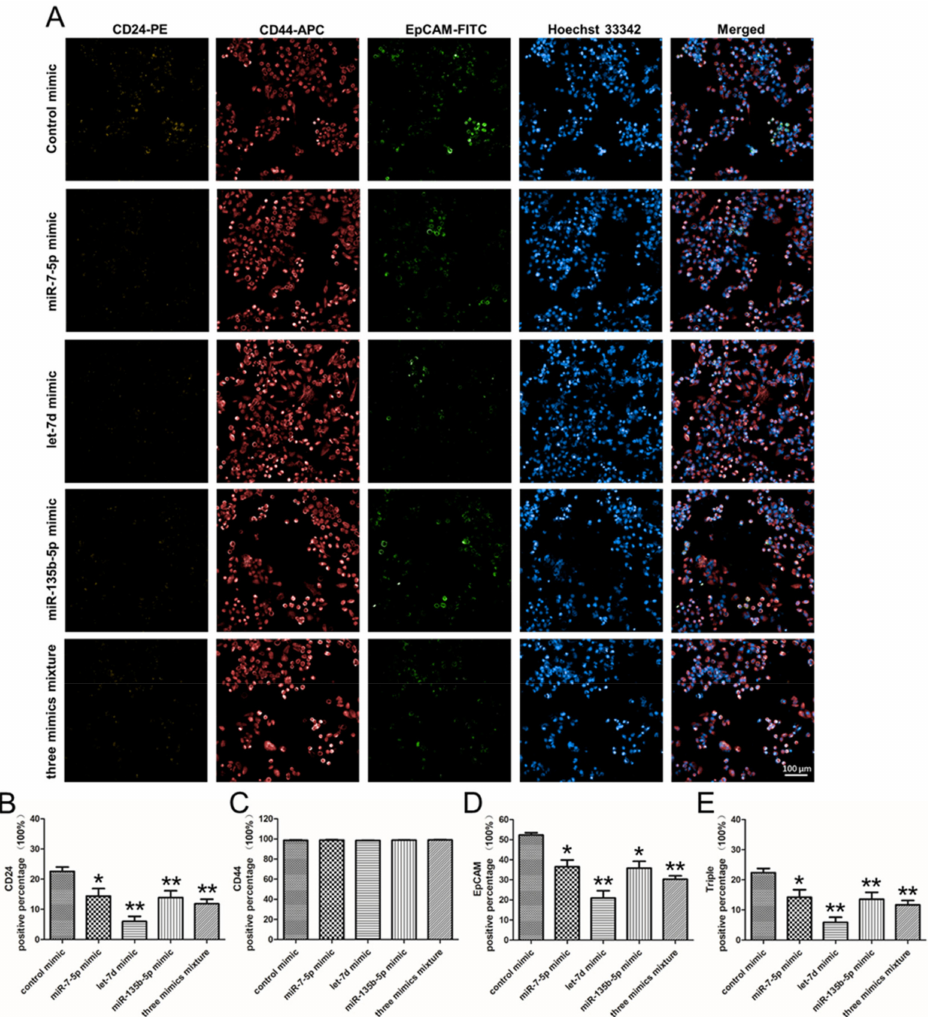
Figure 7. Immunocytochemistry analysis of pancreatic cancer stem cell surface markers CD24, CD44 and EpCAM in PANC-1 cells transfected with miRNA mimics. ( A ) Images of miRNA mimic transfected PANC-1 cells stained with anti-human CD44, anti-human EpCAM and anti-human CD24 antibody. ( B ) The percentage of CD24 + cells was 22.6 ± 2.5% (transfected with control mimic), 14.4 ± 4.3% (miR-7-5p mimic), 6.0 ± 2.9% (let-7d mimic), 13.9 ± 3.9% (miR-135b-5p mimic) and 11.9 ± 2.6% (three mimics). ( C ) In the same order, the percentage of CD44 + cells was 98.7 ± 0.7%, 98.9 ± 0.6%, 98.5 ± 0.4%, 98.8 ± 0.5% and 99.0 ± 0.6%. ( D ) The percentage of EpCAM + cells was 52.3 ± 1.9%, 36.6 ± 5.7%, 21.0 ± 6.2%, 35.8 ± 5.9% and 30.3 ± 2.8%, follow the same order. ( E ) The percentage of CD24 + CD44 + EpCAM + cells was 22.4 ± 2.4%, 14.2 ± 4.3%, 5.9 ± 2.9%, 13.6 ± 3.9% and 11.7 ± 2.5%, in the order above. Data presented as the mean ± standard deviation (SD) of three independent experiments. * P < 0.05 in comparison with the corresponding cells using Student’s t -test. ** P < 0.01 in comparison with the corresponding cells using Student’s t